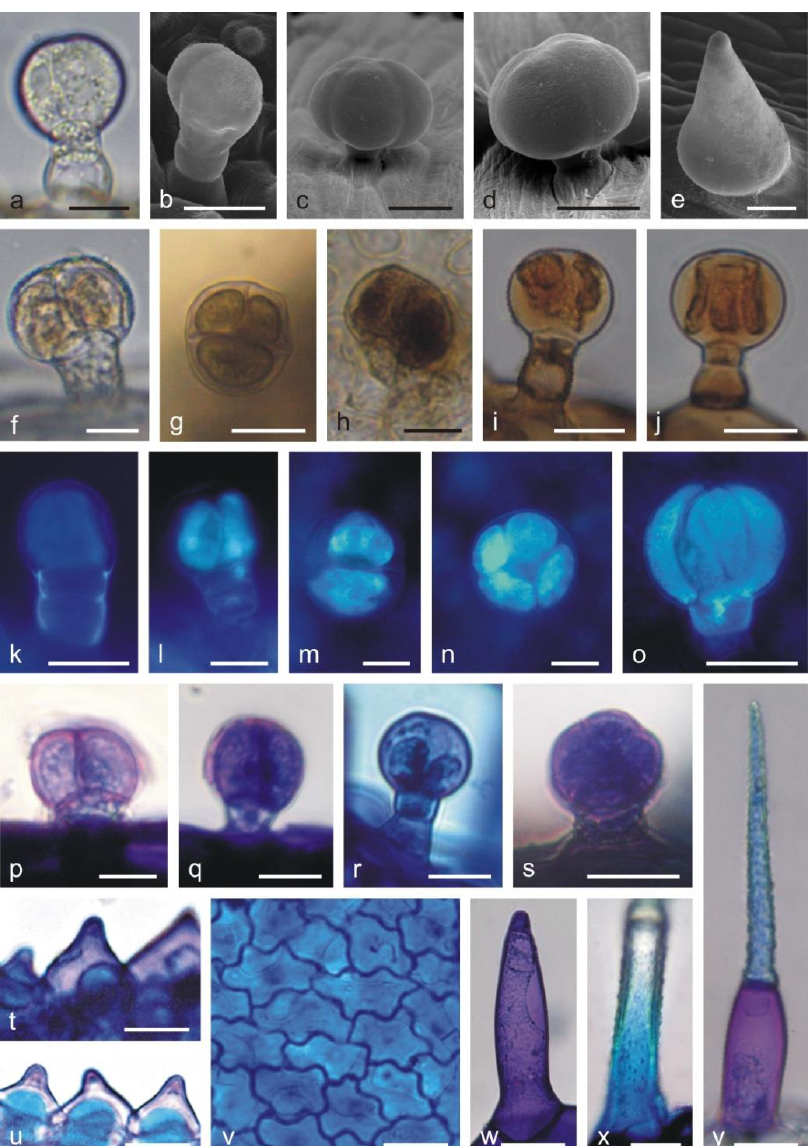
Figure 2. Types of trichomes and papillae on the L. album subsp. album corolla and the results of histochemical assays. ( a , f ) Control trichomes without staining (LM). ( b – e ) SEM images of trichomes. ( g – j , p – y ) Histochemical reactions (LM). ( k – o ) fluorescence microscopy (FM) images of trichomes. ( a ) Capitate trichome with a 1-celled head. ( b ) Capitate trichome with a 2-celled head. ( c ) Capitate trichome with a 4-celled head. ( d ) Peltate trichome. ( e ) Conical trichome. ( f ) Capitate trichome with a bicellular head and yellow content in the head cells. ( g , h ) Phenolic compounds stained black in the heads of trichomes after the application of ferric trichloride. ( g ) Capitate trichome with a 3-celled head. ( h ) Peltate trichome. ( i , j ) Brown color of tannins in trichomes stained with potassium dichromate. ( k – o ) Blue autofluorescence in different capitate and peltate ( o ) trichomes indicating the presence of phenolic acids. ( p – r ) Tannins in capitate trichomes stained blue after Toluidine blue O treatment. ( s ) Peltate trichome stained blue after Toluidine blue O treatment. ( t – u ) Phenolic compounds in papillae stained blue after Toluidine blue O treatment. ( v ) Phenolic compounds visible in abaxial epidermis cells of the upper lip after Toluidine blue O treatment. ( w ) Non-glandular conical trichome from the corolla tube stained purple (pectins) after Toluidine blue O treatment. ( x , y ) Non-glandular trichomes containing phenolic compounds (blue) visible after Toluidine blue O treatment. Scale bars: 30 µ m ( c , d , h , i , q , r , w , y ), 20 µ m ( a , b , f , g , j , k , o , p , s , t , u , v ), 10 µ m ( e , l , m , n , x